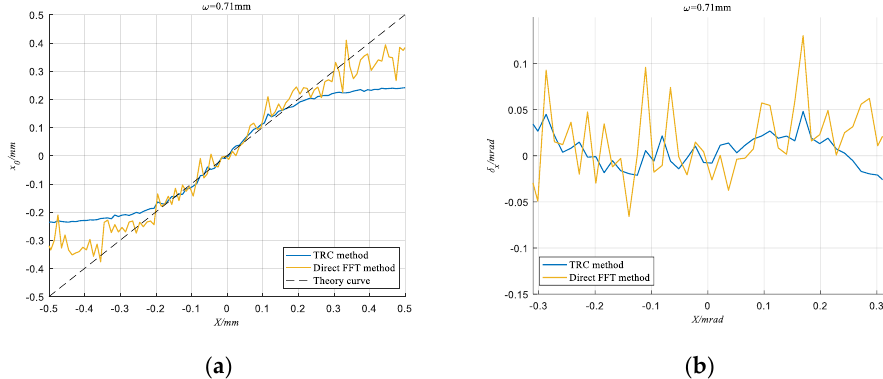
Figure 12. When ω = 0.71 mm and SNR = − 17.86 dB, detection results of TRC method and direct FFT method. ( a ) The Calculated coordinate curve; ( b ) Absolute error.